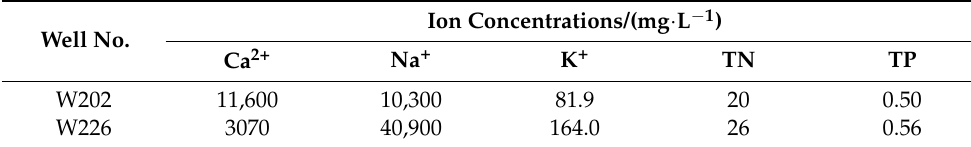
Table 2. Dissolved ion content in the water